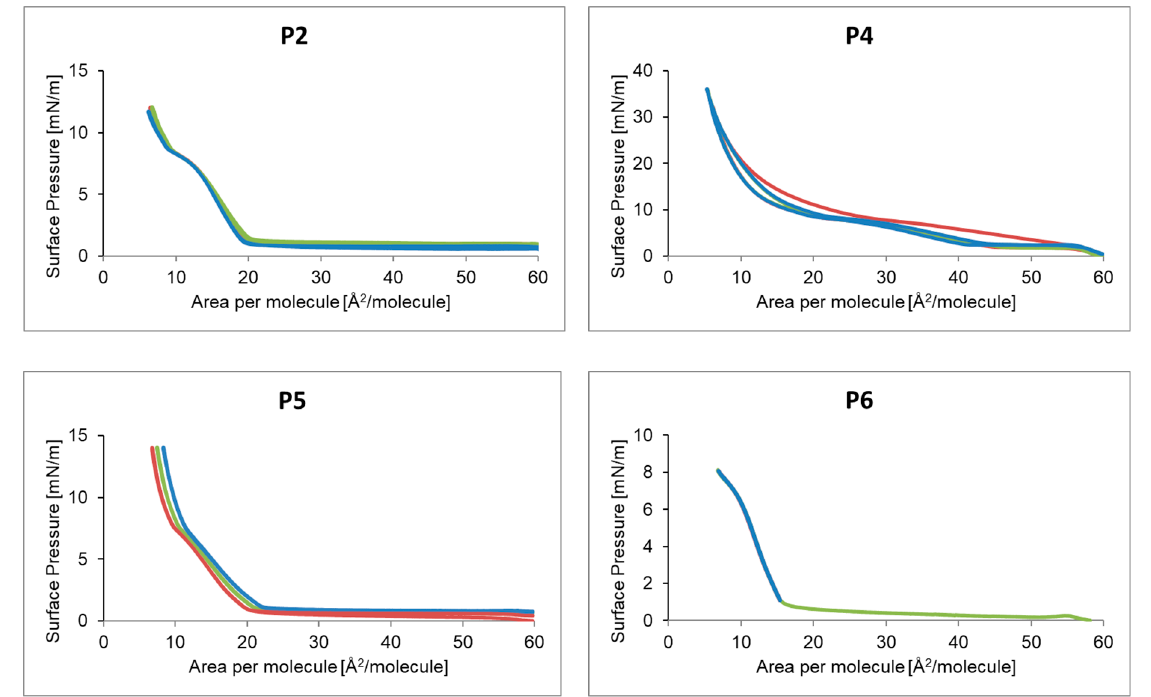
Figure 4. Hysteresis of the peptide P2, P4–P6 for the number of molecules equal to 2.08 10 16 . Loop 1 (-), Loop 2 (-), Loop 3 (-).